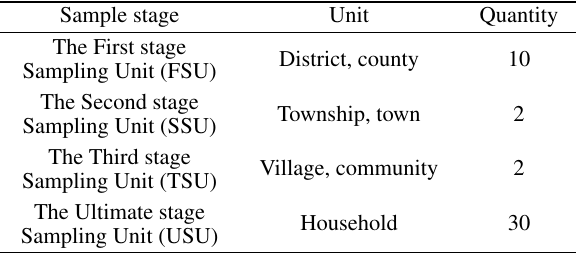
Table 1 Sampling stage and corresponding sampling unit and